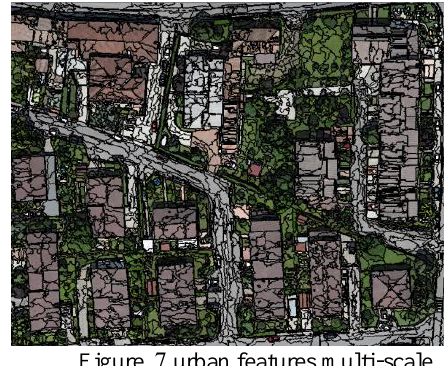
Figure . 7 urban features multi-scale Segmentation of Ortho photo made from taken images from UAV